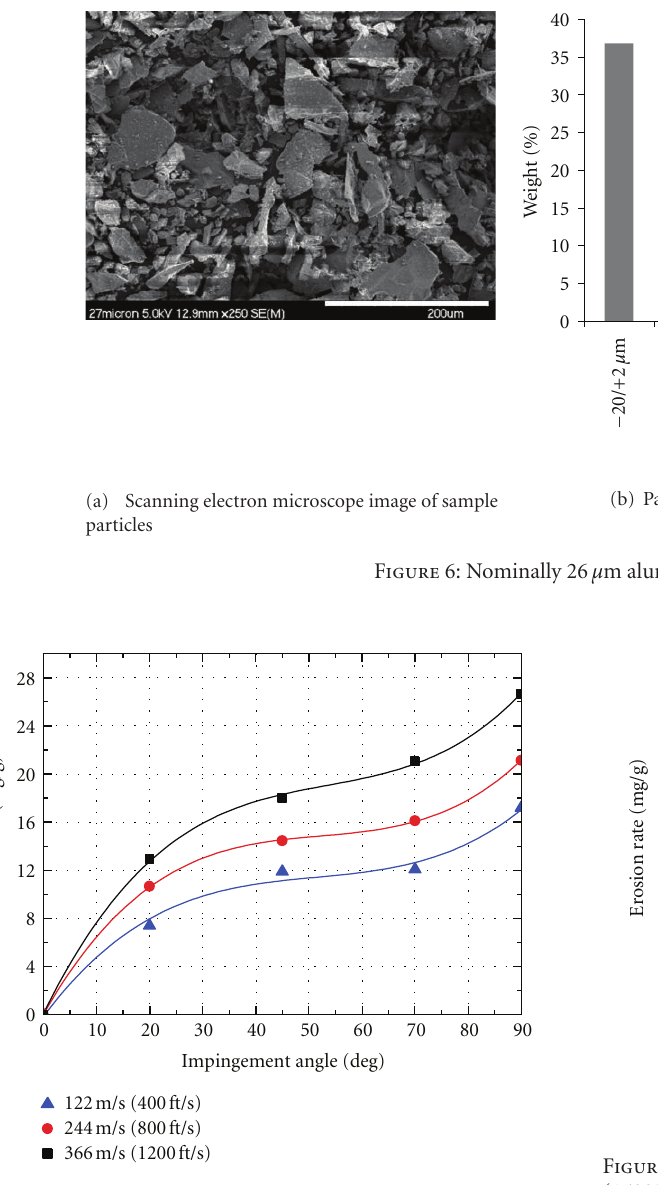
Figure 7: TBC erosion rates by 26 μ m alumina particles at 982 ◦ C (1800 ◦ F).